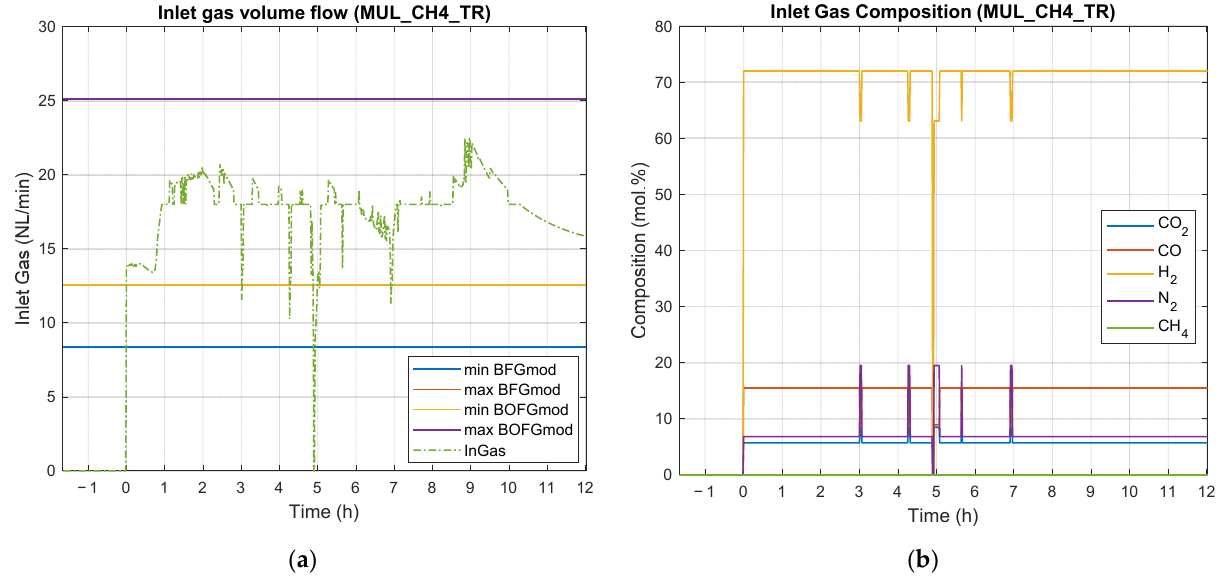
Figure 10. SC1. Control strategy for MUL_CH4_TR. ( a ) Inlet gas volume flow; ( b ) inlet gas composition.